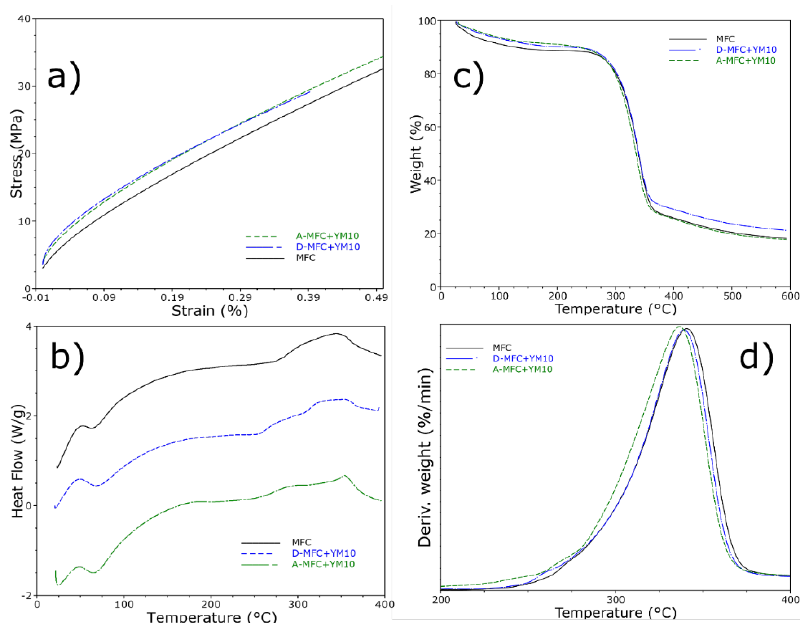
Figure 2. ( a ) Stress−strain curves for tensile tests in DMA, ( b ) differential scanning calorimetry and ( c ) thermogravimetric analysis with its ( d ) first derivative for the MFC films.